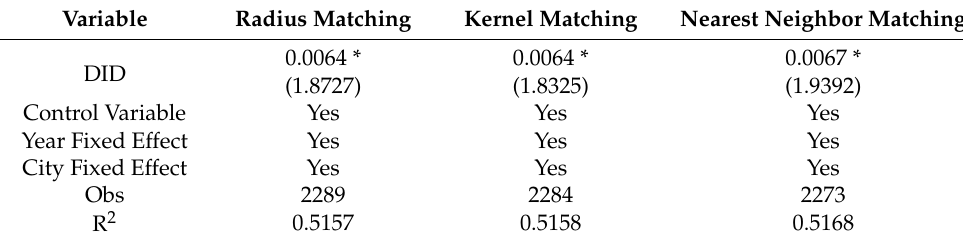
Table 2. PSM-DID test